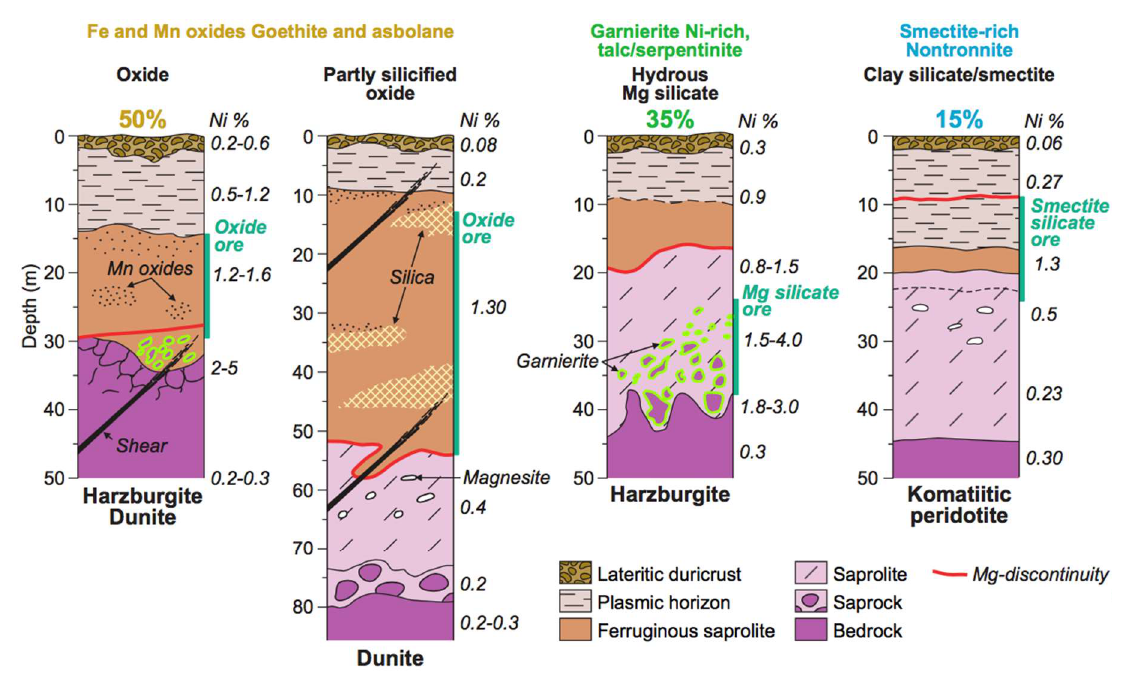
Figure 2. Typical weathering profiles developed on ultramafic rocks with absolute and residual accumulation of Ni and Co (Modified from [25]).